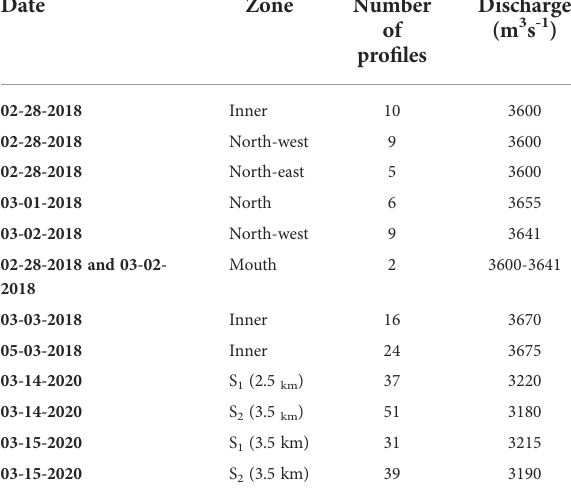
TABLE 2 Location of salinity pro fi les, temperature, density, and fl ow values measured for the 2018 and 2020 dry